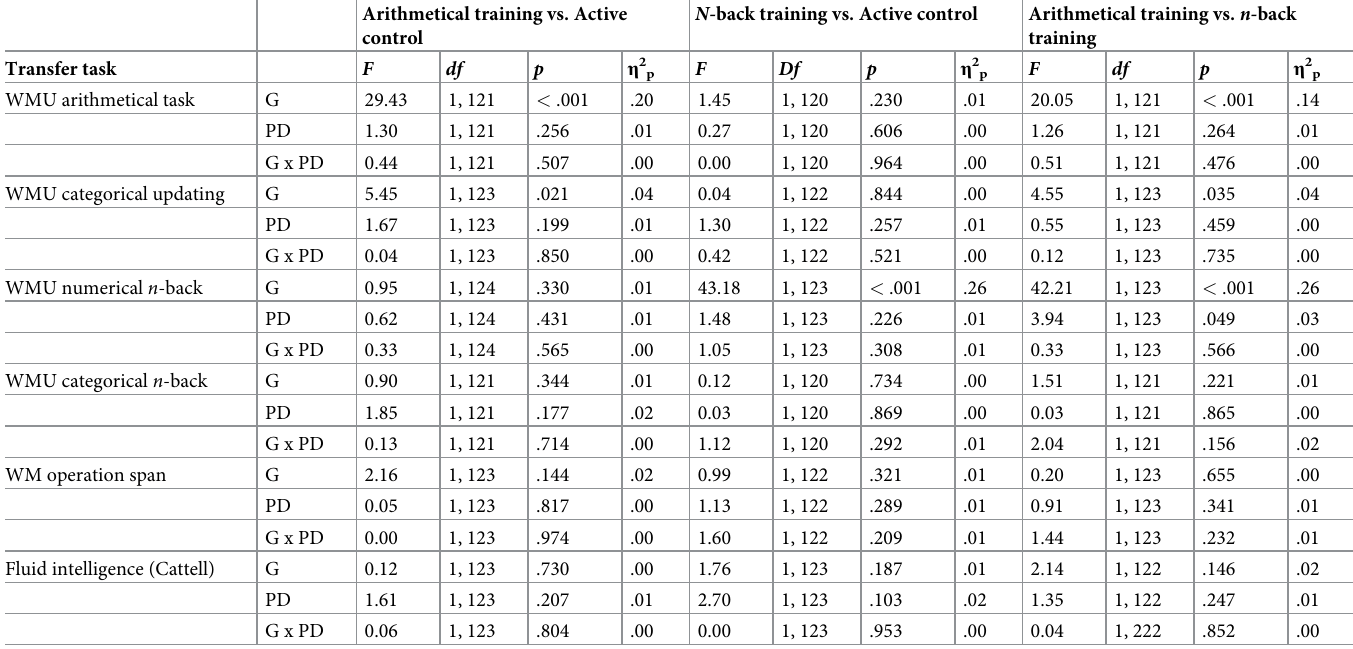
Table 3. Results of three sets of two-way ANOVAs for the measures of interest, with group and practice distribution as between-subjects factors. Arithmetical training vs. Active N -back training vs. Active control Arithmetical training vs. n -back control